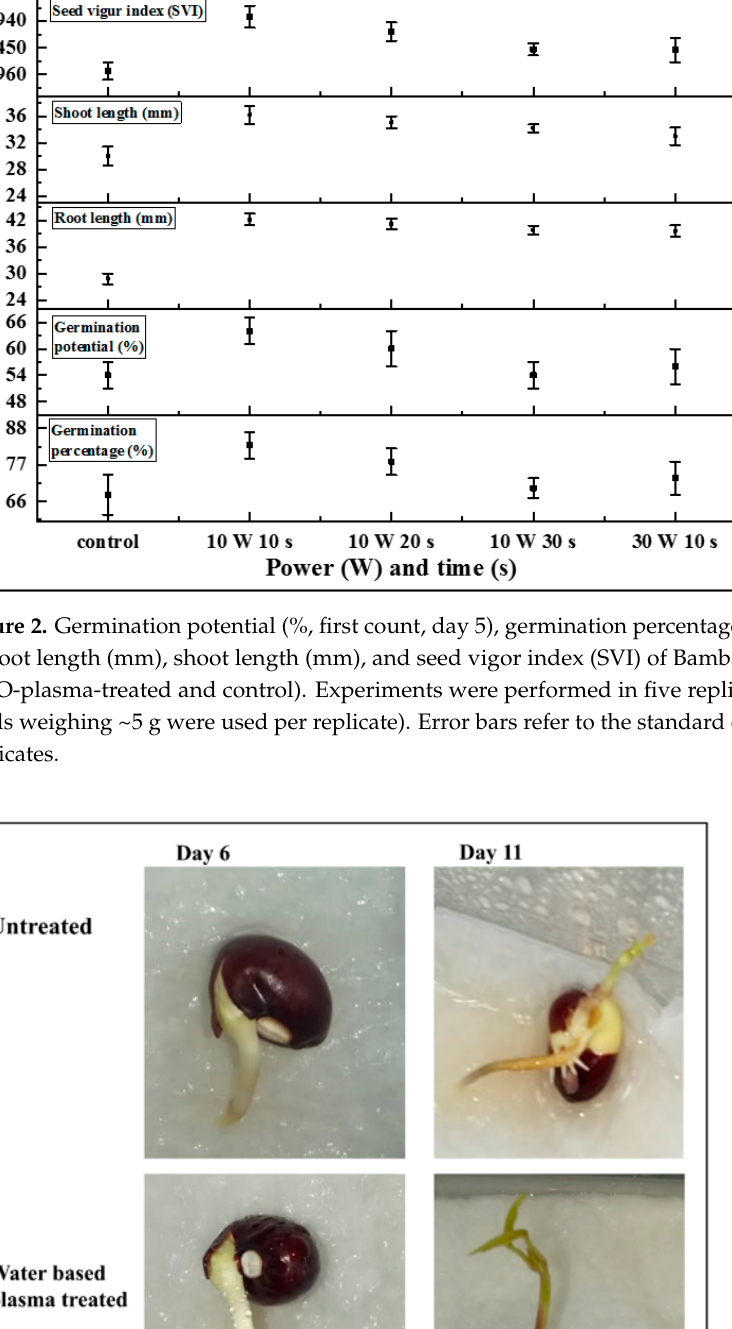
15 s; there, the WCA values of treated seeds registered 0° (complete wetting), improved from 115° (untreated) [35]. While that study and the present work differ in the monomers used and the degree of wettability achieved, both demonstrate a significant reduction in WCA. In the current study, H 2 O plasma treatment with more aggressive parameters (e.g., 10 W 30 s and 30 W 10 s) did not necessarily produce the lowest possible WCAs, but rather all treatments yielded quite similar WCAs amongst themselves (Figure 4). Likewise, dif- ferent plasma treatment durations (from 10 to 30 s) also did not significantly impact the WCA, as the discharge power of 10 W was evidently sufficient to exceed the wettability threshold and maintain the WCA based on the physical and chemical changes observed with FESEM and XPS, discussed below. This discharge power probably signified the threshold WCA, beyond which additional physical-chemical changes do not affect the mechanisms associated with the germination process.